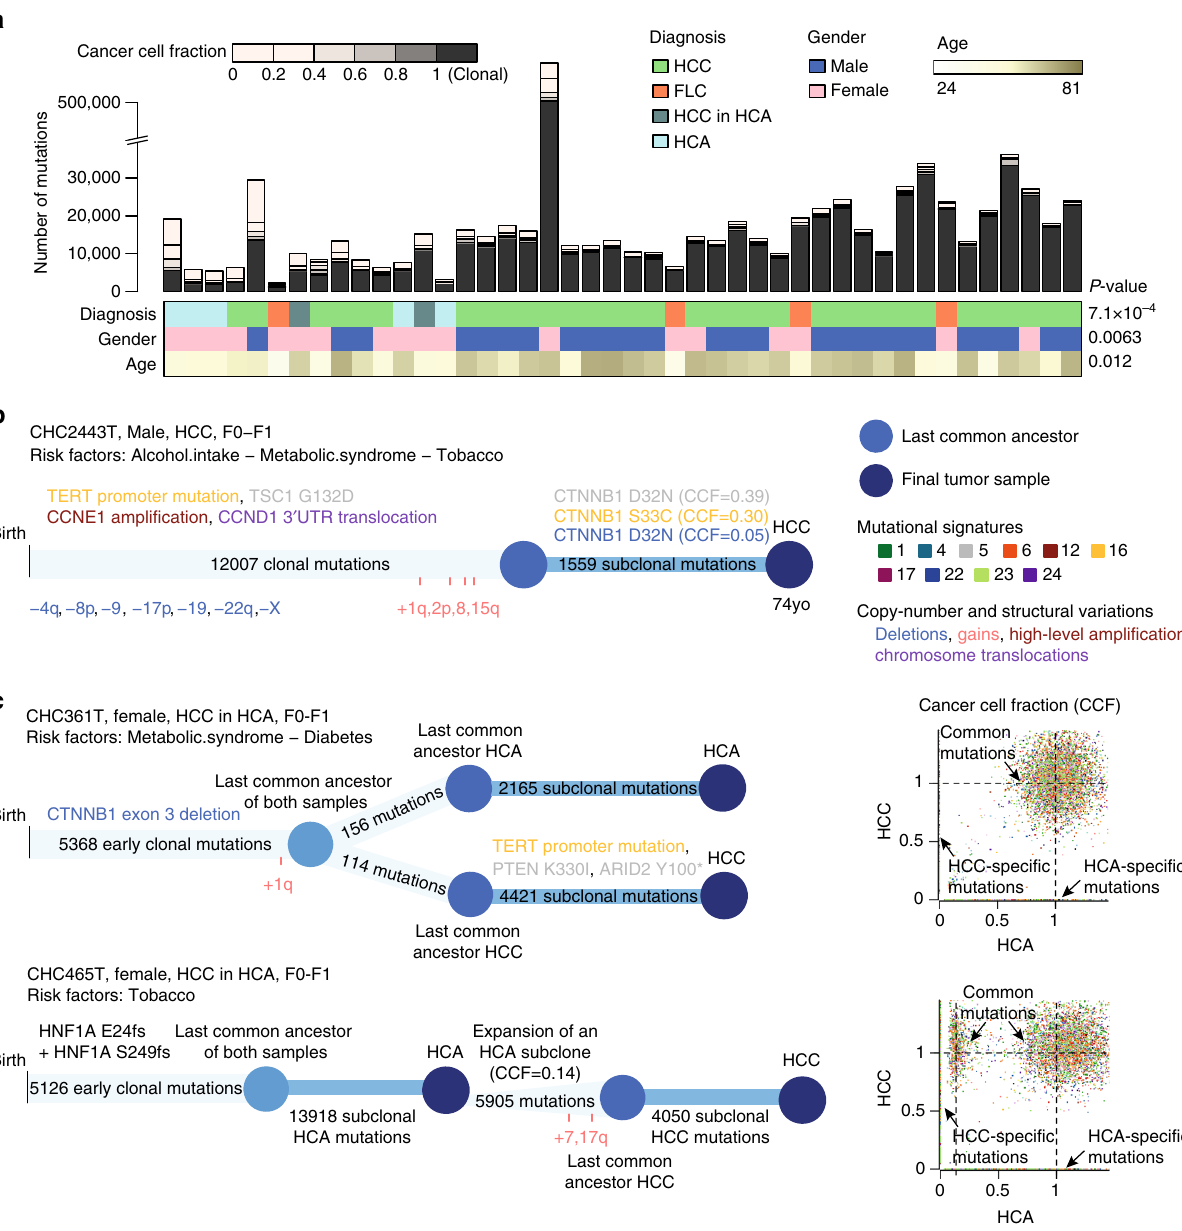
Fig. 4 Clonal architecture and natural history of liver tumors. a Number of clonal and subclonal mutations identi fi ed in 44 liver tumors. A color code indicates the number of mutations with a cancer cell fraction (proportion of tumor cells harboring the mutation) between 0 and 1 (clonal mutations). Tumors are ordered according to their proportion of subclonal mutations and signi fi cantly associated clinical features are represented below. b Clonal history of an hepatocellular carcinoma displaying 3 different subclonal mutations of CTNNB1 . Driver mutations and copy-number alterations in the clonal and subclonal compartments are indicated with a color code indicating the type of event and the most likely signature of origin, as represented in the legend. Copy-number alterations are indicated and duplications are positioned according to their timing in point mutation time. c Clonal histories of two cases of adenoma-to-carcinoma progressions. In CHC361T ( CTNNB1 -related adenoma), few clonal mutations distinguish the adenoma (HCA) and carcinoma (HCC) samples, but 3 subclonal driver mutations were acquired in the carcinoma part. In CHC465T ( HNF1A -related adenoma), the carcinoma developed from a subclone representing 14% of cells in the adenoma sample that further acquired 5905 mutations. In both cases,